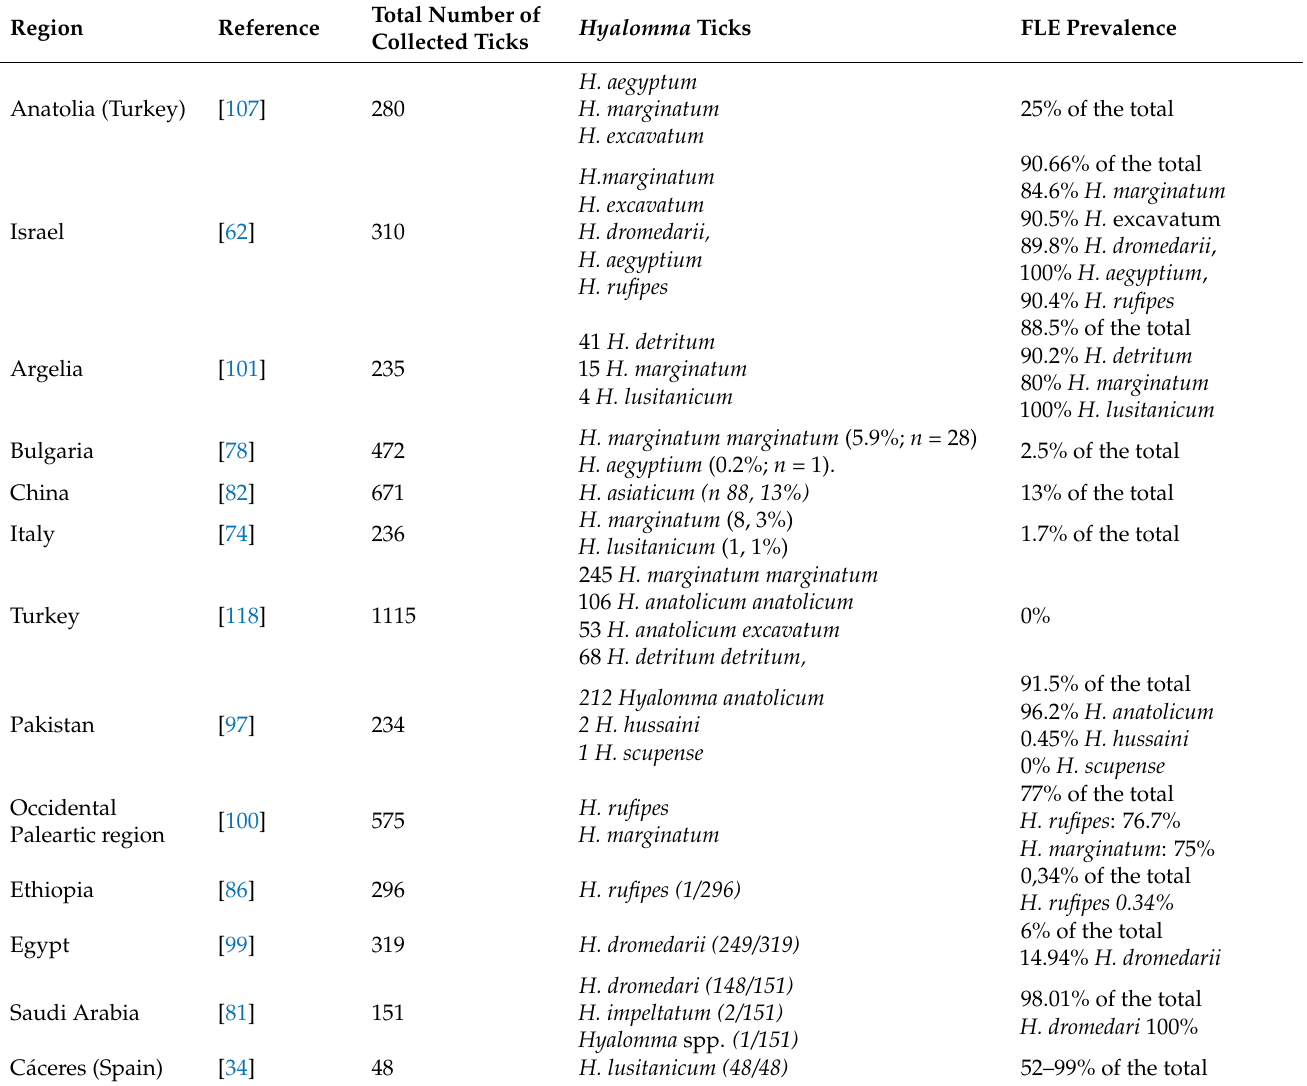
Table 3. The epidemiology of Francisella -like endosymbionts in Hyalomma tick